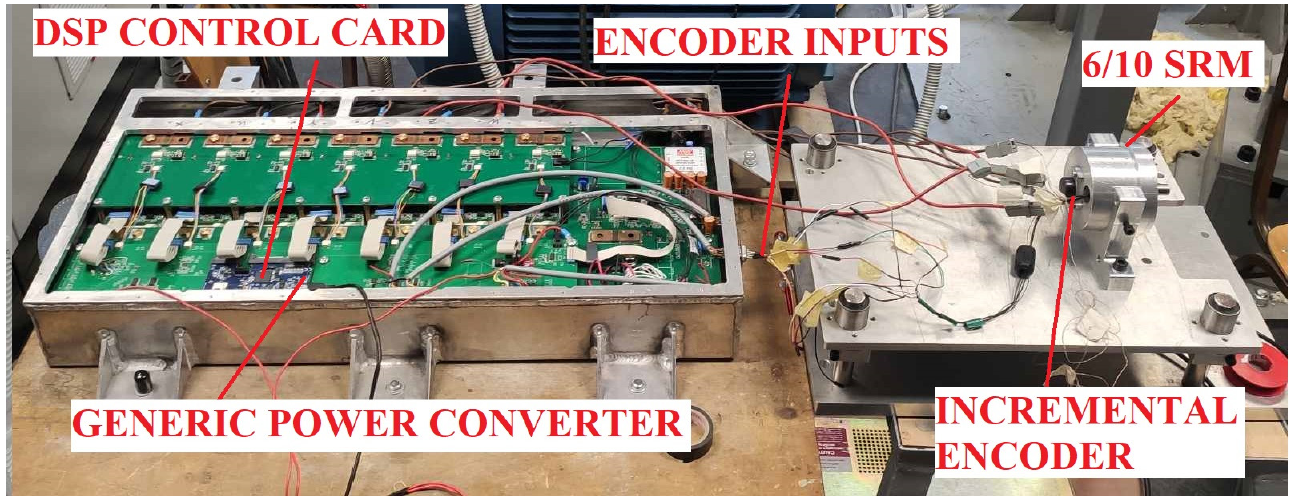
Figure 31. Test bench for dynamic no-load tests of 6/10 SRM prototype.